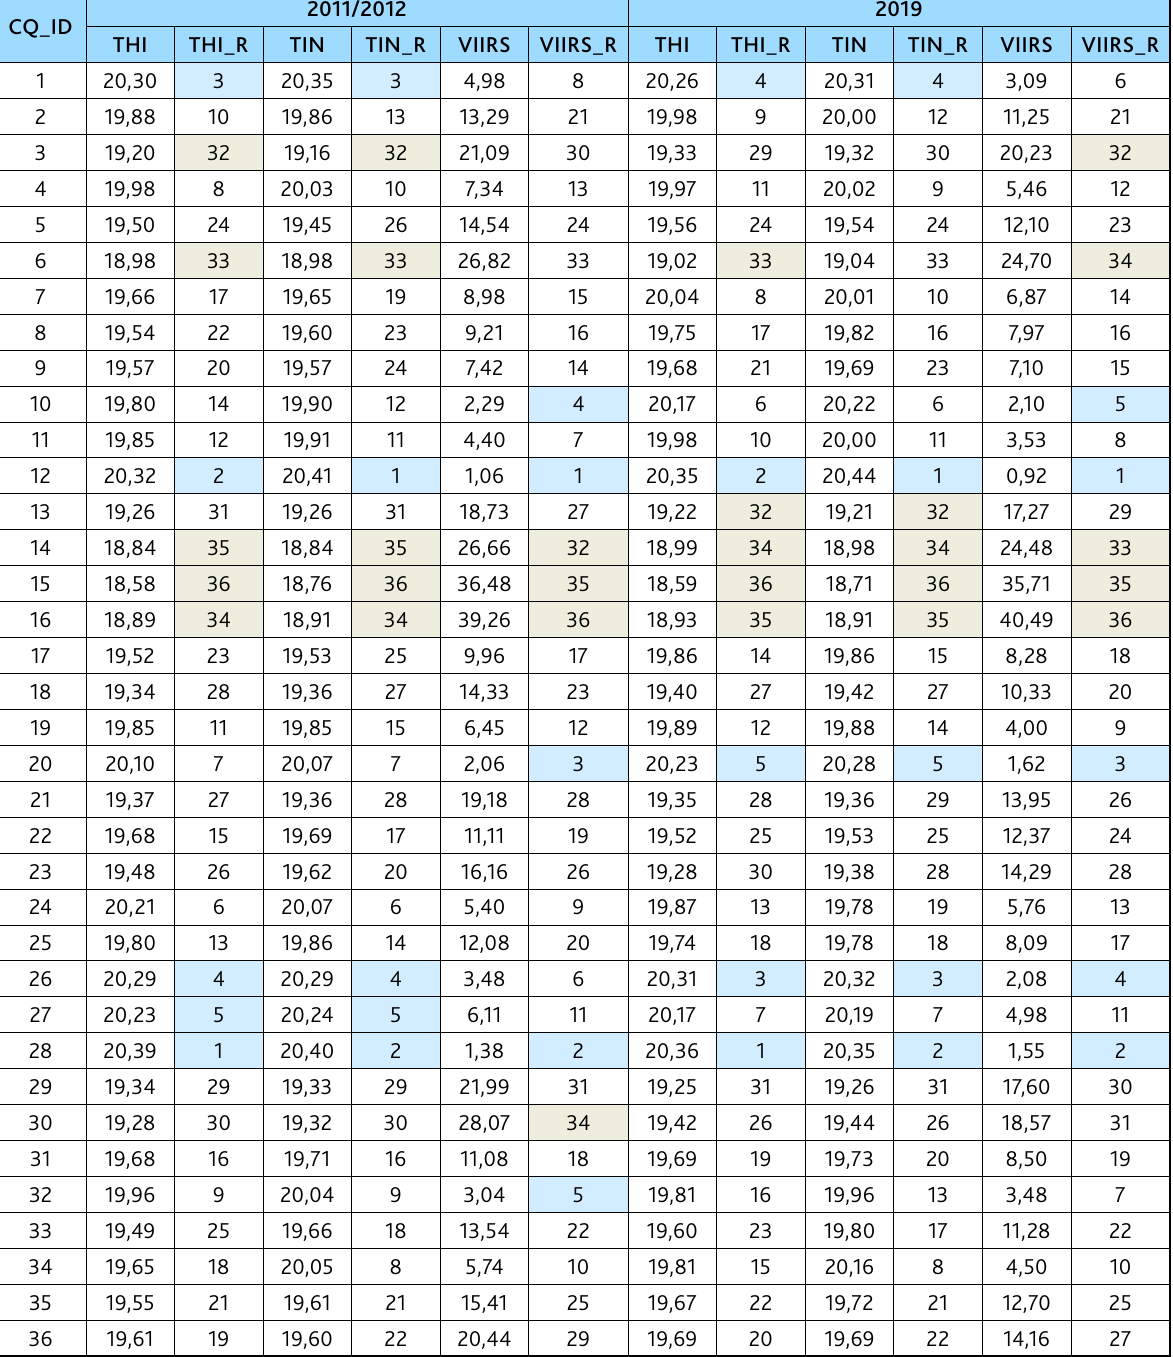
Table 2. Average values and rankings for the neighbourhoods interpreted from raster